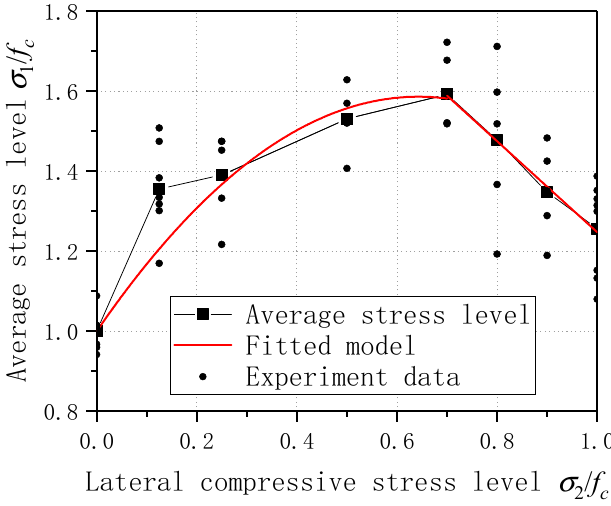
ECC is the highest when the lateral pressure level C = 0.7, reaching 50.44 MPa. When the lateral pressure level is 0.125, the peak stress has been increased by 1.36 times, indicating that when a small amount of lateral restraint is provided, the compressive strength is significantly improved compared with uniaxial compression.